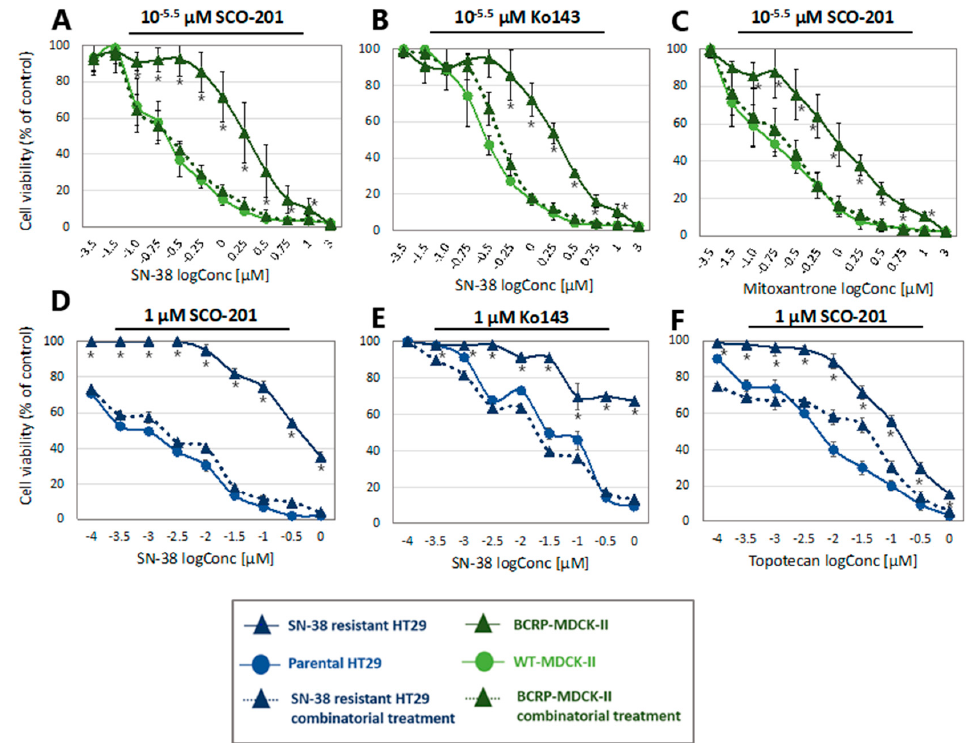
Figure 2. SCO-201 reversed drug resistance in multidrug resistance (MDR) cells. Cell viability of wild-type or breast cancer resistance protein (BCRP)-overexpressing MDCK-II cells and SN-38-sensitive or -resistant HT29 cells. Cell viability is indicated as percentage of untreated control, and error bars indicate percentage SD determined on the basis of n = 3–4. Note that some error bars might be invisible due to the size of the data labels. Control conditions consisted of full growth medium. ( A – C ) Wild-type and BCRP-overexpressing MDCK-II cells treated with either chemotherapy alone or in combination with 10 − 5.5 µ M SCO-201 or Ko143. ( D – F ) Parental and SN-38-resistant HT29 cells treated with either chemotherapy alone or in combination with 1 µ M SCO-201 or Ko143. Statistical di ff erence ( p < 0.05) between mono-treatment and combination treatment of the resistant cell lines is marked by * (Student’s t -test (two-tailed, type